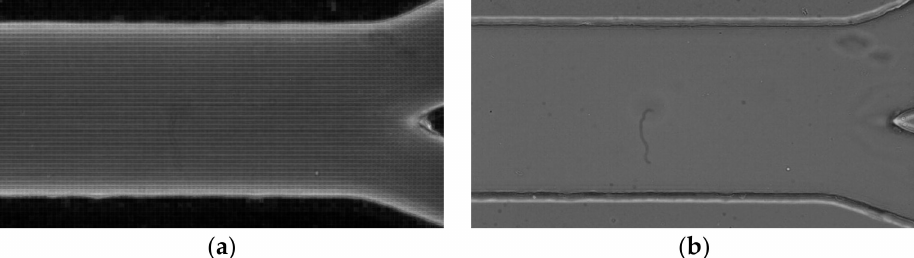
Figure 11. ( a ) Image obtained by applying the standard deviation projection and ( b ) image obtained by applying the median